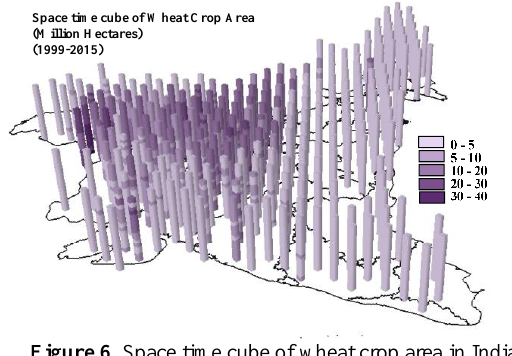
Figure 6 . Space time cube of wheat crop area in India